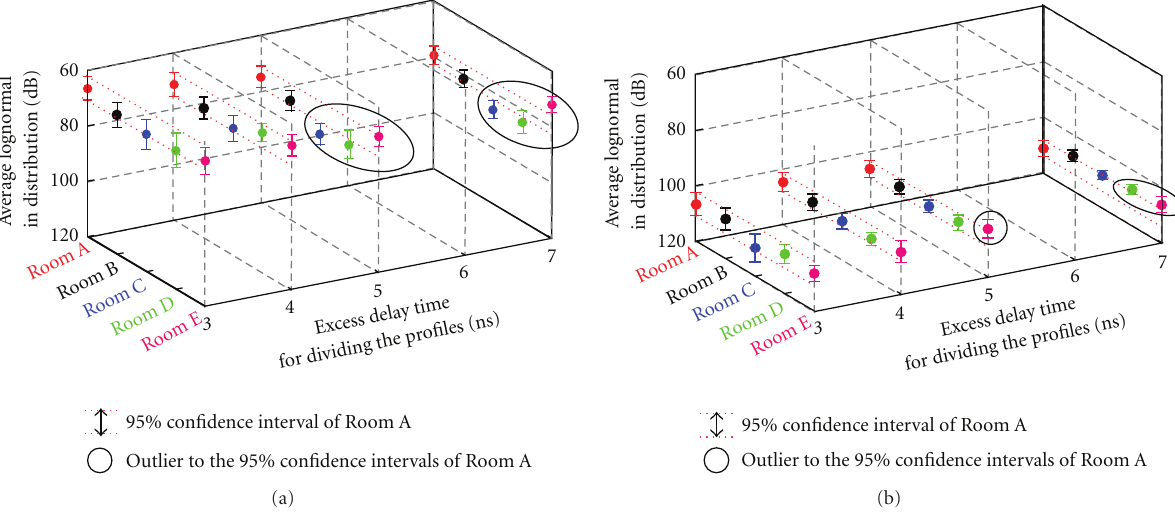
Figure 15: Averages in lognormal distribution fit to the propagation loss for Rooms A to E: (a) LOS and (b) NLOS. The dashed lines are the 95% confidence intervals of Room A (a radio anechoic chamber). The averages encircled by ovals are outliers to the 95% intervals of Room